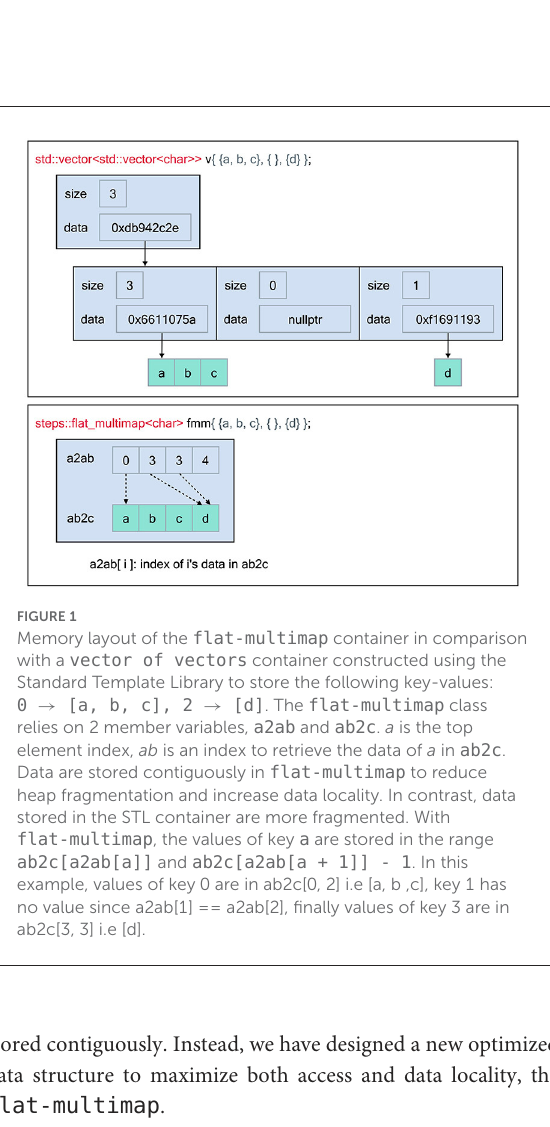
Figure 1 illustrates the memory layout of the flat-multimap container in comparison with a